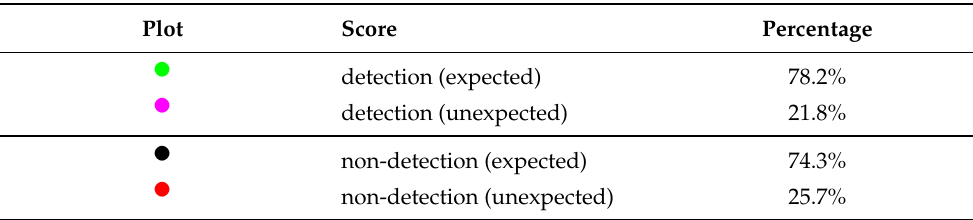
Table 8. Tabular overview for the calculation in percent of the expected and unexpected detection and non-detections with numerical example for the measurement in Figure 10.